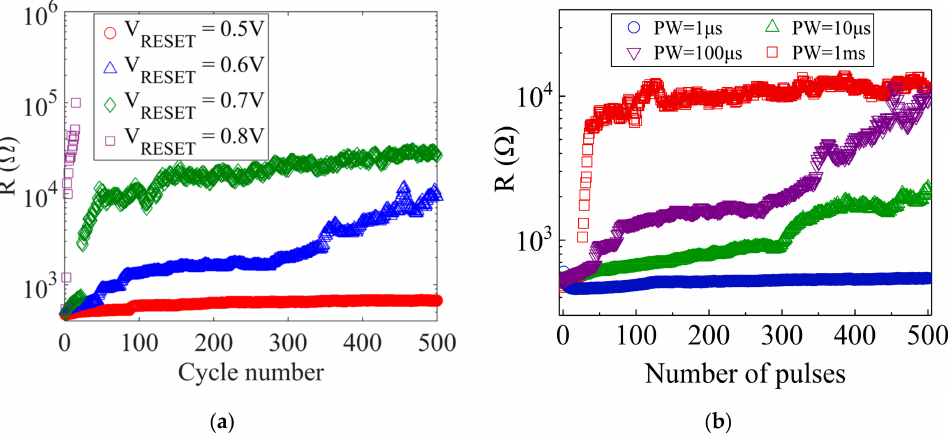
Figure 4. ( a ) Device resistance applying RESET pulses departing from LRS for different pulse amplitudes (V RESET ) with constant pulse width (100 µ s). ( b ) Device resistance applying RESET pulses departing from LRS for different pulse widths (PW) with V RESET = 0.6 V.